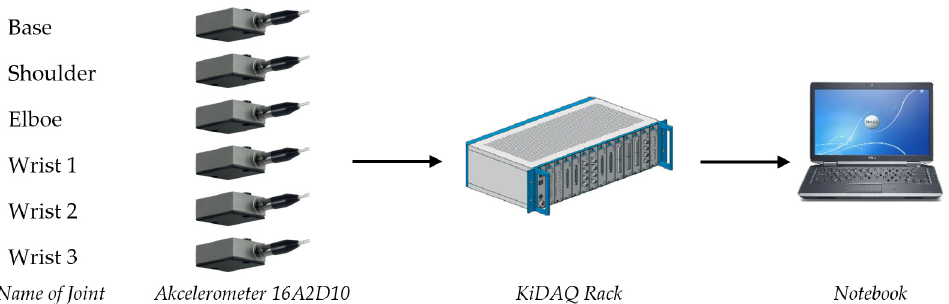
Figure 5. Measuring chain for vibration measurement.